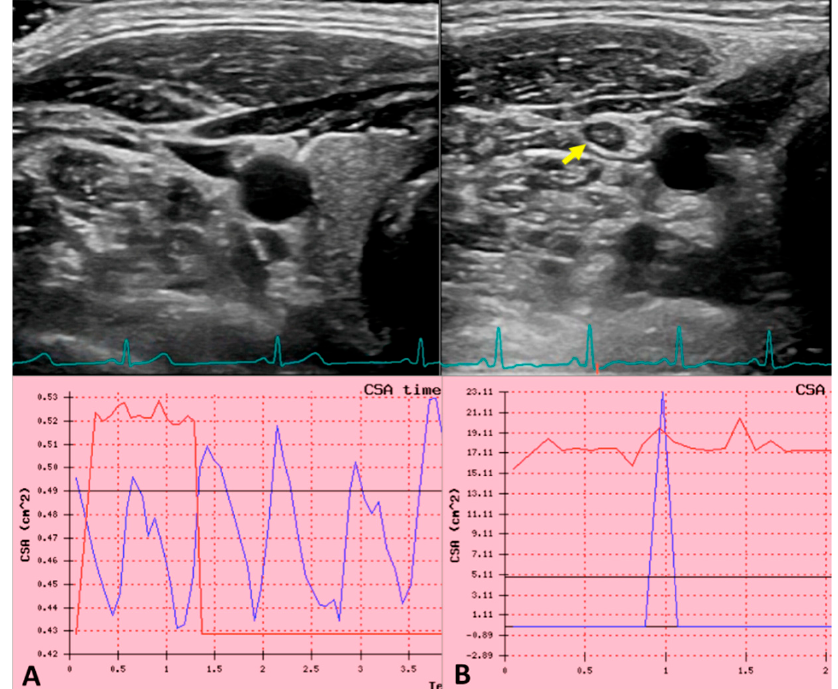
Figure 2. Ultrasound jugular venous pulse in normal and in internal jugular vein thrombosis (IJVthr) cases. ( A ) B-mode ultrasound (US) of the IJV and the common carotid artery at J2 level, in the transversal aspect of the neck. The green line corresponds to the ECG trace. The blue line in the diagram corresponds to the recorded JVP i.e., the sequence of cross-sectional area variation for cardiac beat. The red line corresponds to the synchronized ECG trace. ( B ) The yellow arrow shows an IJVthr. The disappearance of the sequential peaks of the ultrasound JVP is well apparent.